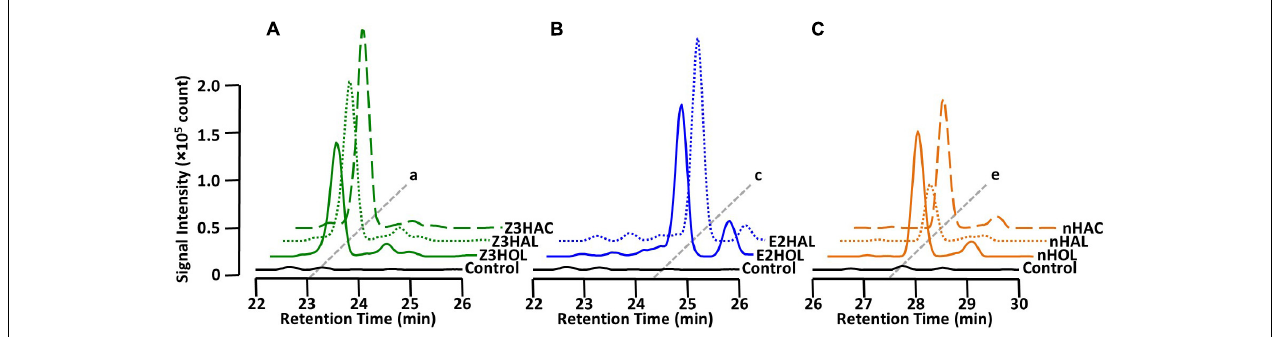
FIGURE 4 | Diglycoside accumulation in GLV-exposed tomato. Comparison of the chromatograms from (A) Z3HAL-, Z3HOL-, and Z3HAC-exposed leaf extracts at m/z = 417. ( Z )-3-Hexenyl vicianoside (a) accumulated in the ( Z )-form GLVs exposed plants. (B) E2HAL- and E2HOL-exposed leaf extracts at m/z = 417. ( E )-2-Hexenyl vicianoside (c) was accumulated in both ( E )-forms of GLV- exposed plants. (C) nHAL-, nHOL-, and nHAC-exposed leaf extracts at m/z = 419. n -Hexyl vicianoside (e) was accumulated in the n -form GLVs exposed plants. The chromatogram of the control leaf extract is shown by the black